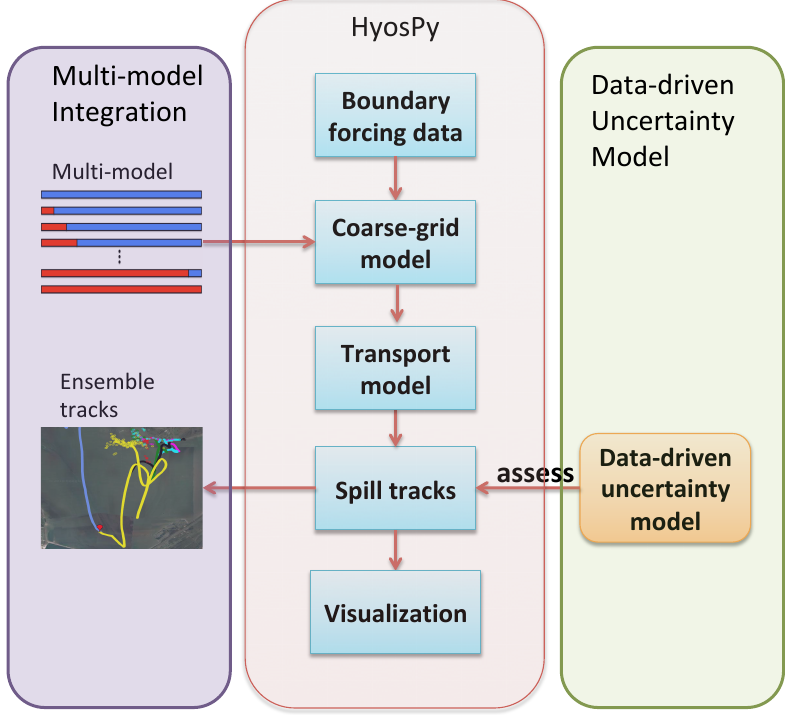
Figure 3. The HyosPy system with the data-driven uncertainty model and the multi-model